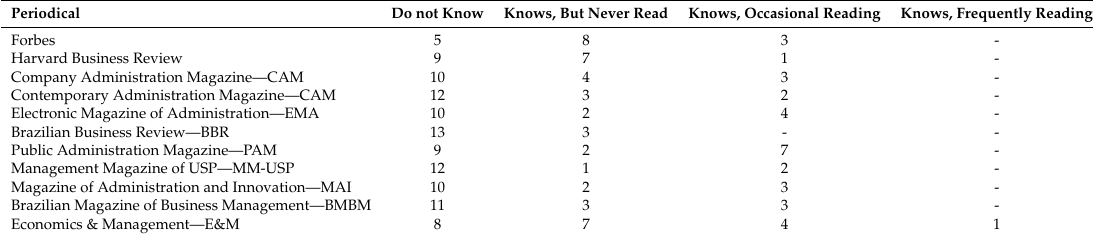
Table 3. Frequency on consultation of professional